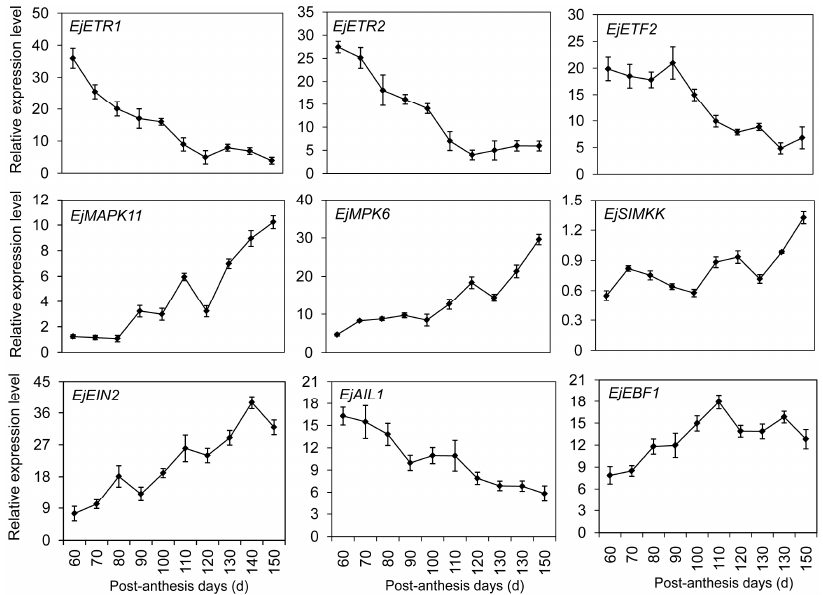
Figure 7. Transcription profiles of differentially expressed genes DEGs involved in the ethylene signal pathway using qRT-PCR. Each point is the mean of three determinations. Vertical bars, if larger than symbols, represent the standard error of the mean ( n = 3).